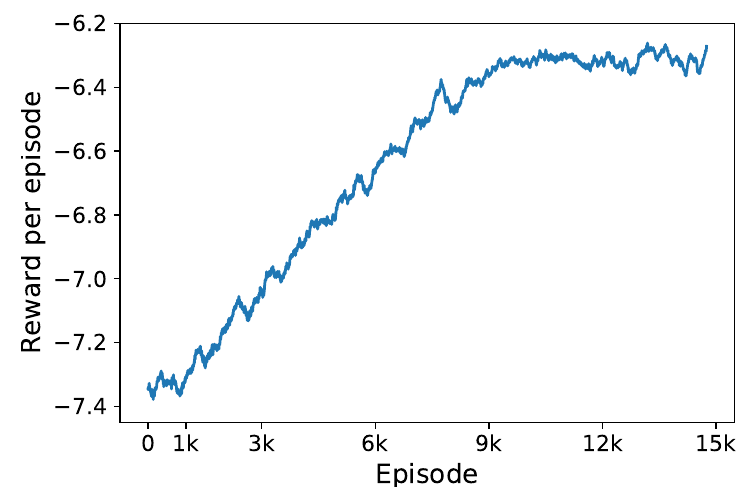
Figure 7. Learning curve with respect to the rewards obtained by proposed DRL approach.